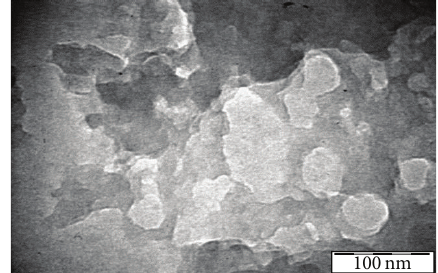
Figure 8: TEM image of FeNPs synthesized using Gardenia leaves